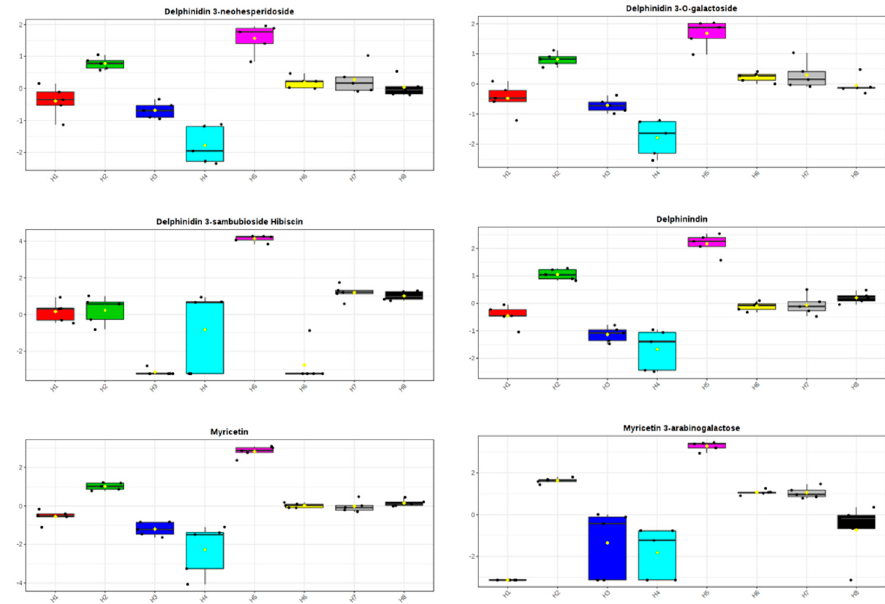
Figure 4. Metabolites with high abundance in Hibiscus calyces extracted with 70% ethanol (H5). The y-axis represents the log2 values of metabolite abundance.